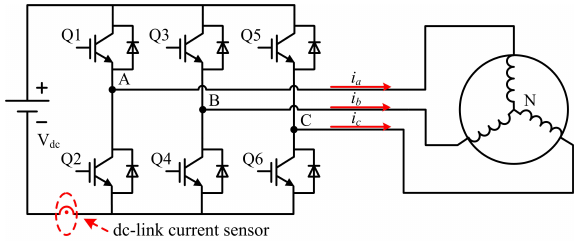
Figure 1. The circuit topology of the single DC-link current sensor method.